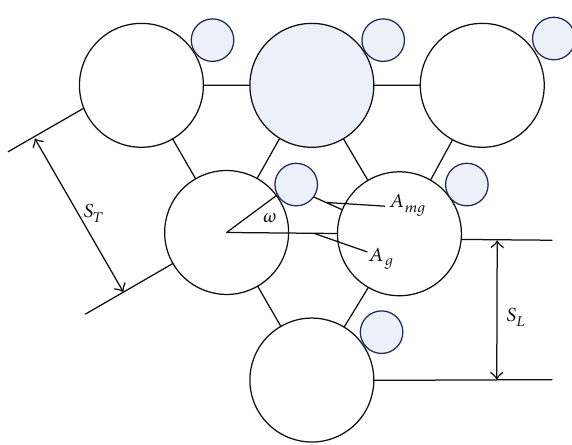
Figure 4: Fuel assembly design and subchannel identification.